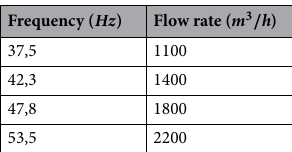
Table 2. Relation between frequency and flow values used for estimation of the transfer functions.